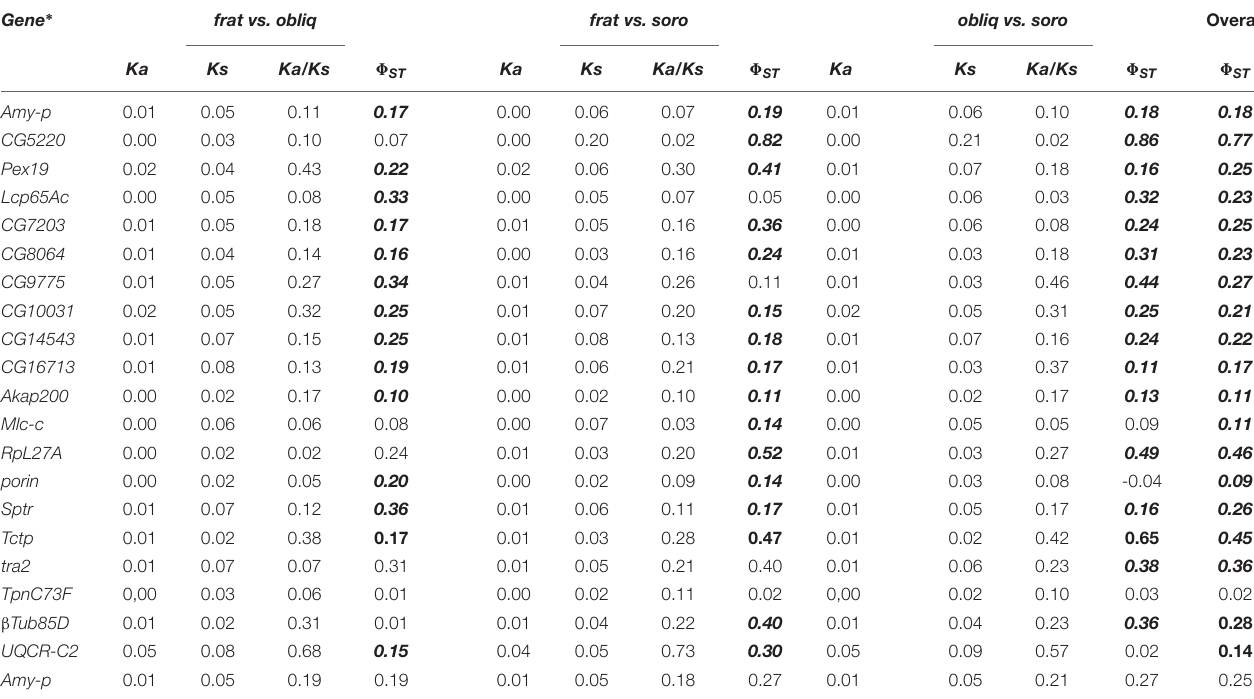
Results are shown for the mean ± standard errors across 20 genes for each Anastrepha species. N, average number of sequences; N S , total number of sites; S, number of variable sites; Eta, total number of mutations; h, number of haplotypes; H d , haplotype diversity; π , nucleotide diversity; k, average number of nucleotide differences; θ W , theta. TABLE 2 | Divergence among Anastrepha species at synonymous ( Ks ) and non-synonymous ( Ka ) sites, and genetic structure among species estimated by (cid:56) ST . Gene ∗ frat vs. obliq frat vs. soro obliq vs.